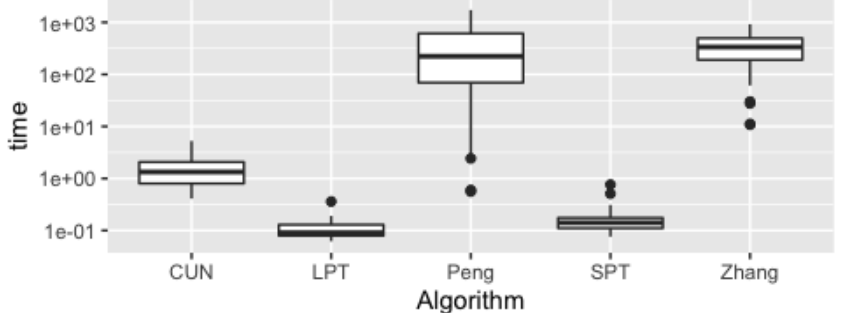
Figure 4. Boxplot of the runtime, in seconds (scientific notation), of algorithms: LPT, SPT, CUN, Peng and Zhang.